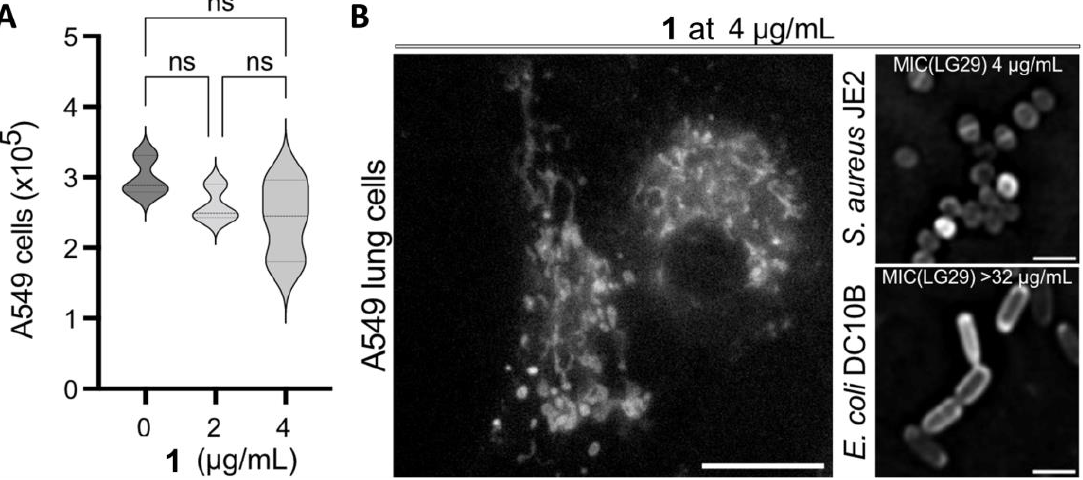
Figure 11. ( A ) A549 viability in the presence of increasing concentration of 1 for 24h. ( B ) WF live-cell imaging of A549 lung cells, S. aureus JE2 strain bacterial cells and E. coli DC10B strain bacterial cells stained with 4 µ g/mL chemosensor 1 with 4 equivalents of Zn 2+ . Scale bars are 20 µ m for A549 and 2 µ m for S. aureus and E. coli images.